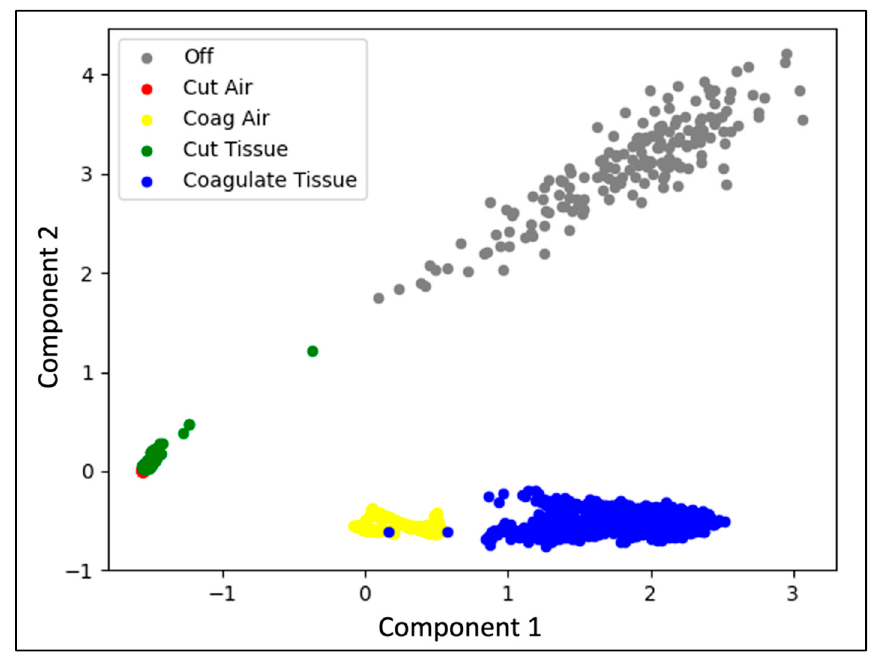
Figure 8. Principal Component Analysis of five cautery states for collection with Valley Lab cautery